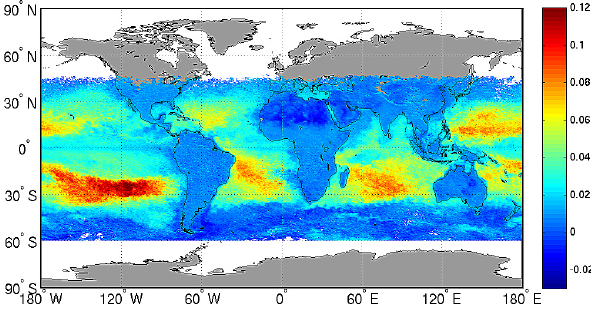
Fig. 5. Monthly mean liquid water optical density at 460nm re- trieved in December